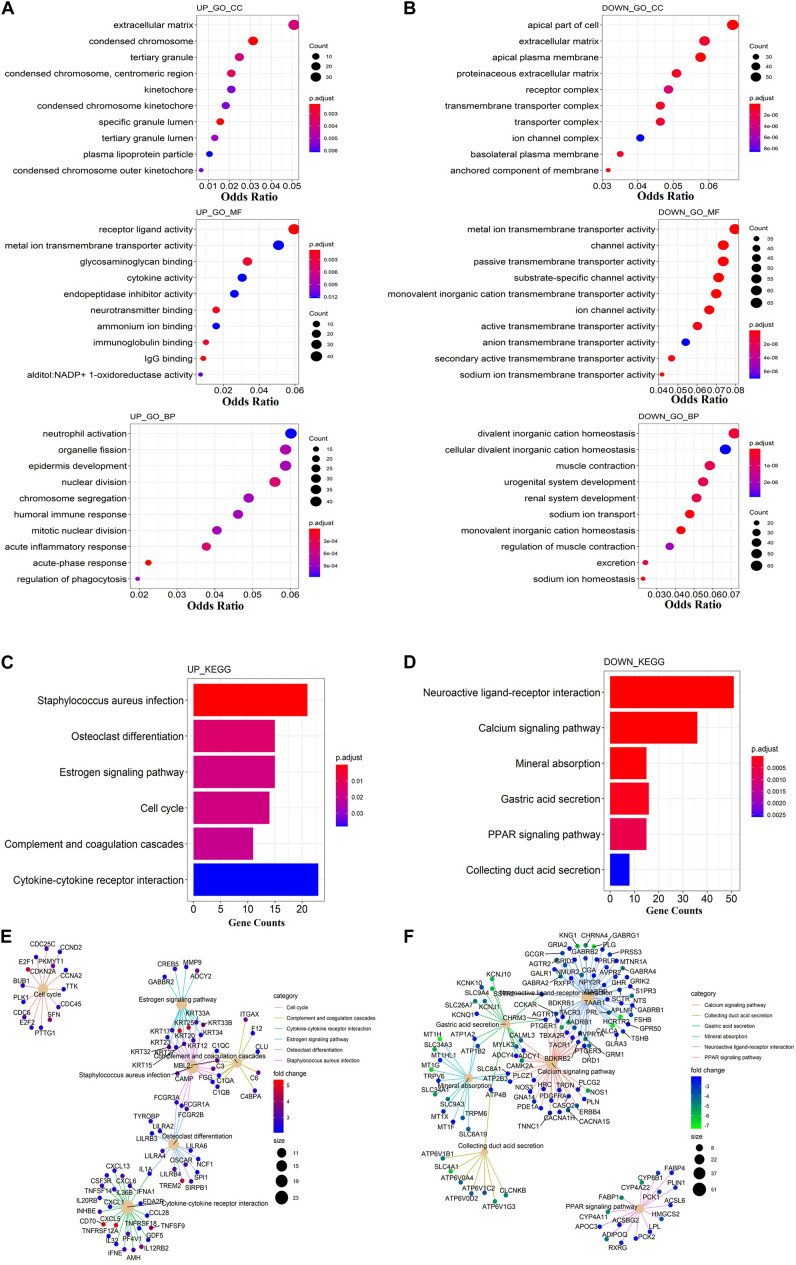
Functional enrichment analysis of DEmRNAs. (A) Gene Ontology enrichment analysis of up-regulated mRNAs. (B) Gene Ontology enrichment analysis of down-regulated mRNAs. (C) KEGG pathway analysis of up-regulated mRNAs. (D) KEGG pathway analysis of down-regulated mRNAs. (E) The netplot of KEGG pathways means the enrichment of up-regulated mRNAs in different pathways. (F) The netplot of KEGG pathways means the enrichment of down-regulated mRNAs in different pathways. The color bar represents the fold change of genes in different pathways. The y-axis represents the gene count. The x-axis represents the enrichment analysis terms. Each plot’s color represents the p-value, while the size represents the gene number in this term.